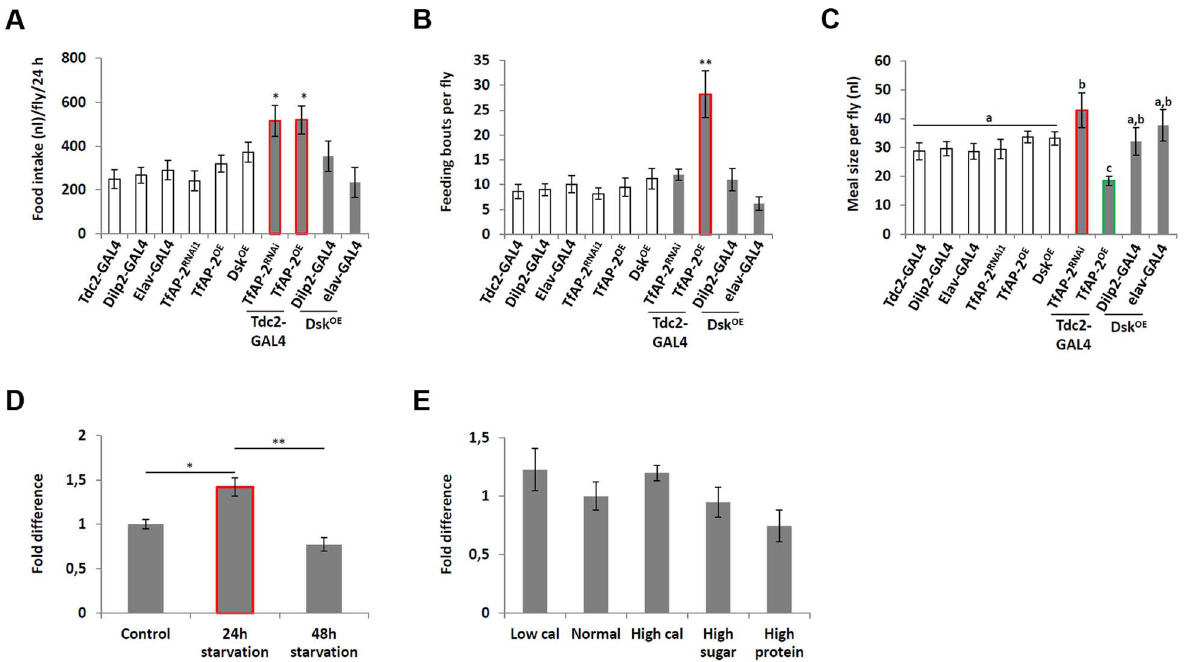
Figure 5. Dsk overexpression does not affect feeding behavior. (A–C) A CAFE assay was used to assess the total food intake (B), the average number of feeding bouts (C) and meal size (D) over a 24 hour period in 5–7 days old adult males. Five males were used for each replicate and the assay was repeated at least 10 times for each genotype. (D) Relative levels of Dsk transcript in the heads of flies starved either for 24 or 48 h. (E) Relative levels of Dsk transcript in the heads of flies kept on various diets for 5 days. (D,E) RNA was collected from the heads of 50, 5–7 day old, males for each genotype. qPCR was repeated at least 7 times for each transcript. (A,B and D: A single asterisk indicates significant difference, a non- parametric Kruskal-Wallis ANOVA was performed with Dunn’s post hoc test for multiple comparisons, P , 0.05, while a double asterisk indicates significant difference P , 0.005). (C: Different letters indicate similar groups (i.e. ‘a’ is significantly different than ‘b’ or ‘c’ and so on, A non-parametric Kruskal-Wallis ANOVA was performed with Dunn’s post hoc test for multiple comparisons, P , 0.05). Error bars represent the SE (SEM).